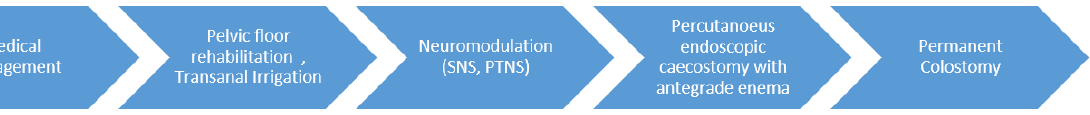
Figure 1. Bowel rehabilitation program (BOREAL) [44].